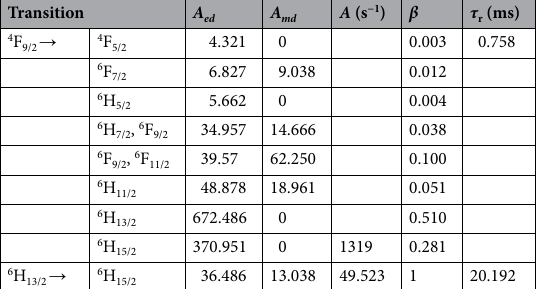
Table 4. Calculated spontaneous radiation probabilities, branching ratios, and radiative lifetime of Dy: CYA crystal.